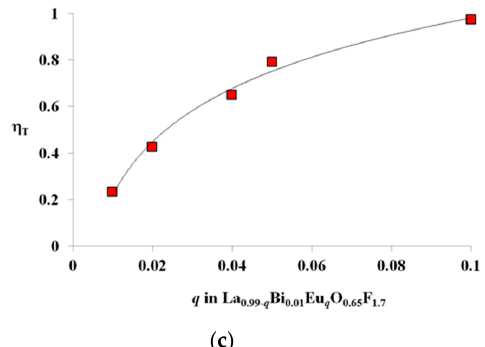
Figure 4. ( a ) The emission spectra of La 0.99- q Bi 0.01 Eu q O 0.65 F 1.7 ( q = 0–0.1) phosphors under 286 nm excitation, ( b ) the plot of I SO /I S versus C Bi-Eu α /3 ( α = 6, 8, 10), and ( c ) energy transfer efficiency from Bi 3+ to Eu 3+ in the phosphors.